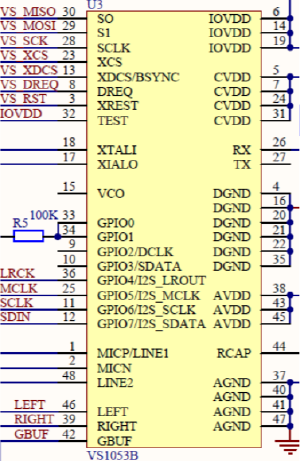
Figure 14. Audio decoding module chip pin interface.